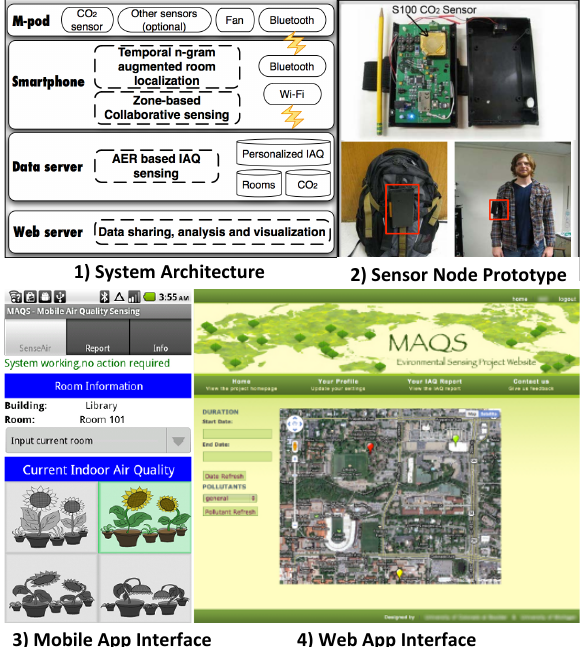
Figure 9. Example of the Community Sensor Network (CSN) system architecture and prototype. Figures are adapted from